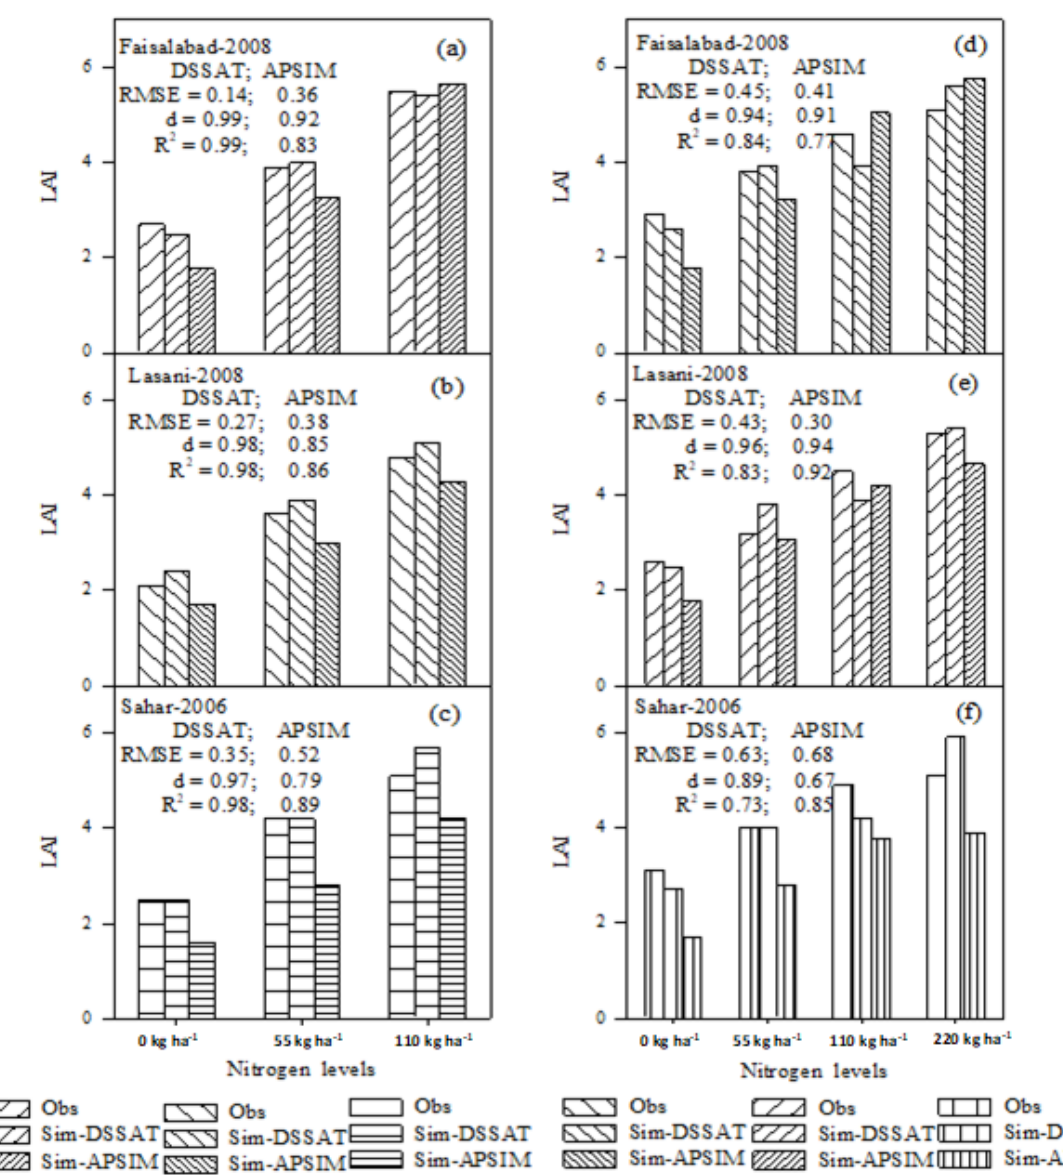
Figure 4. Intercomparison of simulated and observed leaf area index at different nitrogen levels for wheat cultivars during years 2008 – 2009 ( a – c ) and 2009 – 10 ( d – f ).